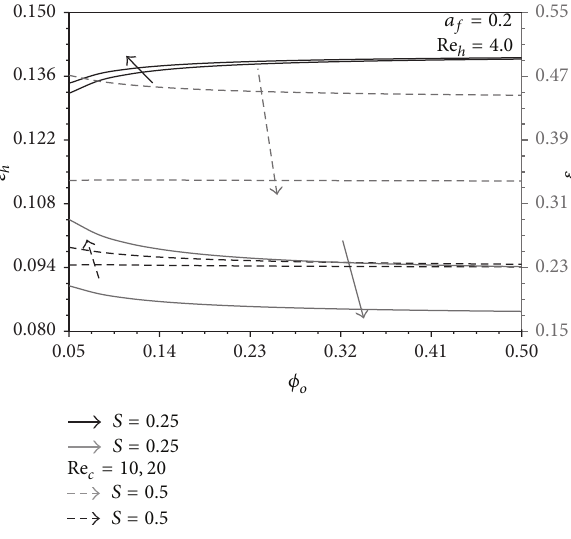
Figure 7: Effects of 𝑎 𝑓 and Re 𝑐 on 𝛾 ℎ and 𝛾 𝑐 . Figure 8: Effects of 𝜙